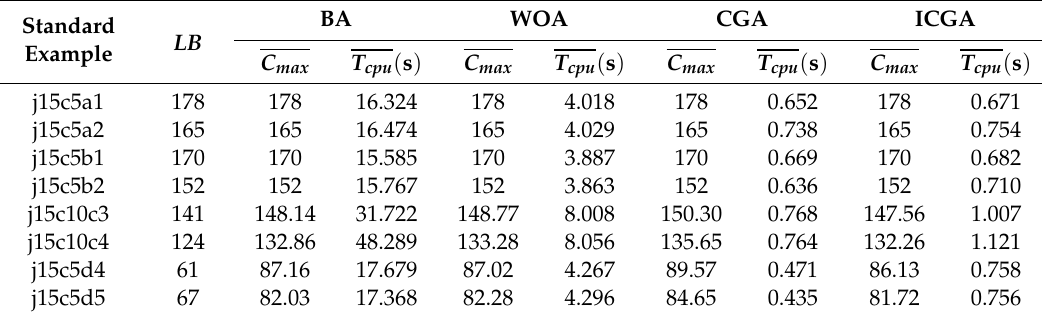
Table 2. Small-scale data test results.